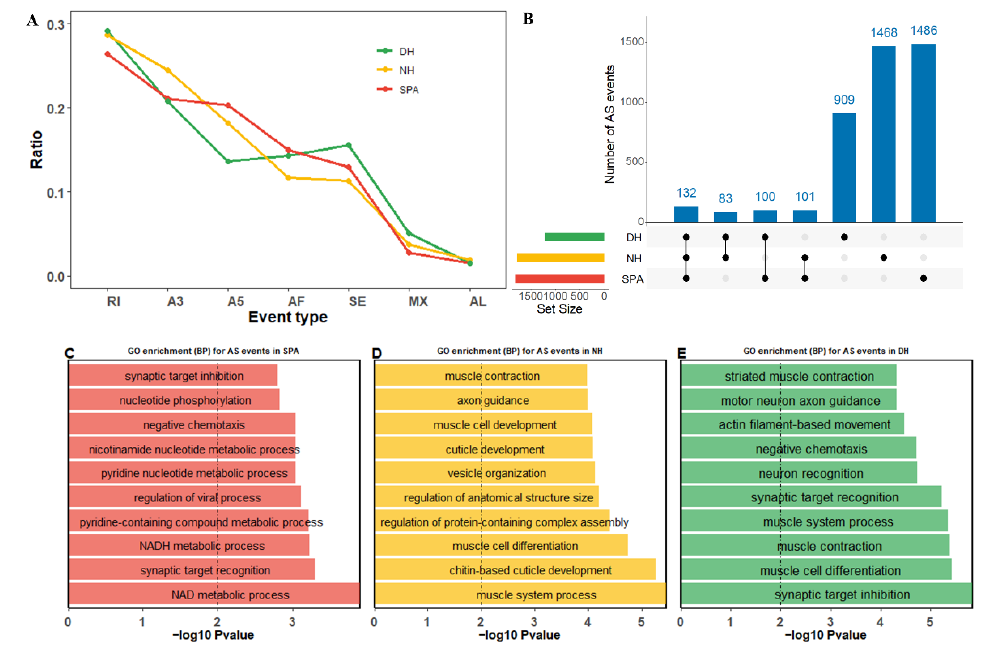
Figure 3. Summary of alternative splicing (AS) events profiling in SPA, NH, and DH. SPA, NH, and DH are indicated by different colors (red, yellow, and green, respectively). ( A ) The proportion of each AS type in SPA, NH, and DH. The Y ‐ axis represents the proportion of different AS events. The X ‐ axis represents different AS event types, including SE (skipped exon), MX (mutually exclusive exon), A5 (alternative 5 ′ splice site), A3 (alternative 3 ′ splice site), RI (retained intron), AF (alternative first exon), and AL (alternative last exon). ( B ) Identified common and specific AS events among SPA, NH, and DH. The barplots on the left represent the size of the datasets of SPA, NH, and DH. Dots and vertical lines indicate the overlapping AS events in the respective comparison. Barplots in the top panels represent the number of AS events. ( C – E ) The top ten significantly biological processes (BP) obtained from Gene Ontology (GO) enrichment analysis using genes with AS events in SPA, NH, and DH, respectively. The Y ‐ axis represents different BP categories. The X ‐ axis represents the corresponding − log10 transformed p ‐ value.